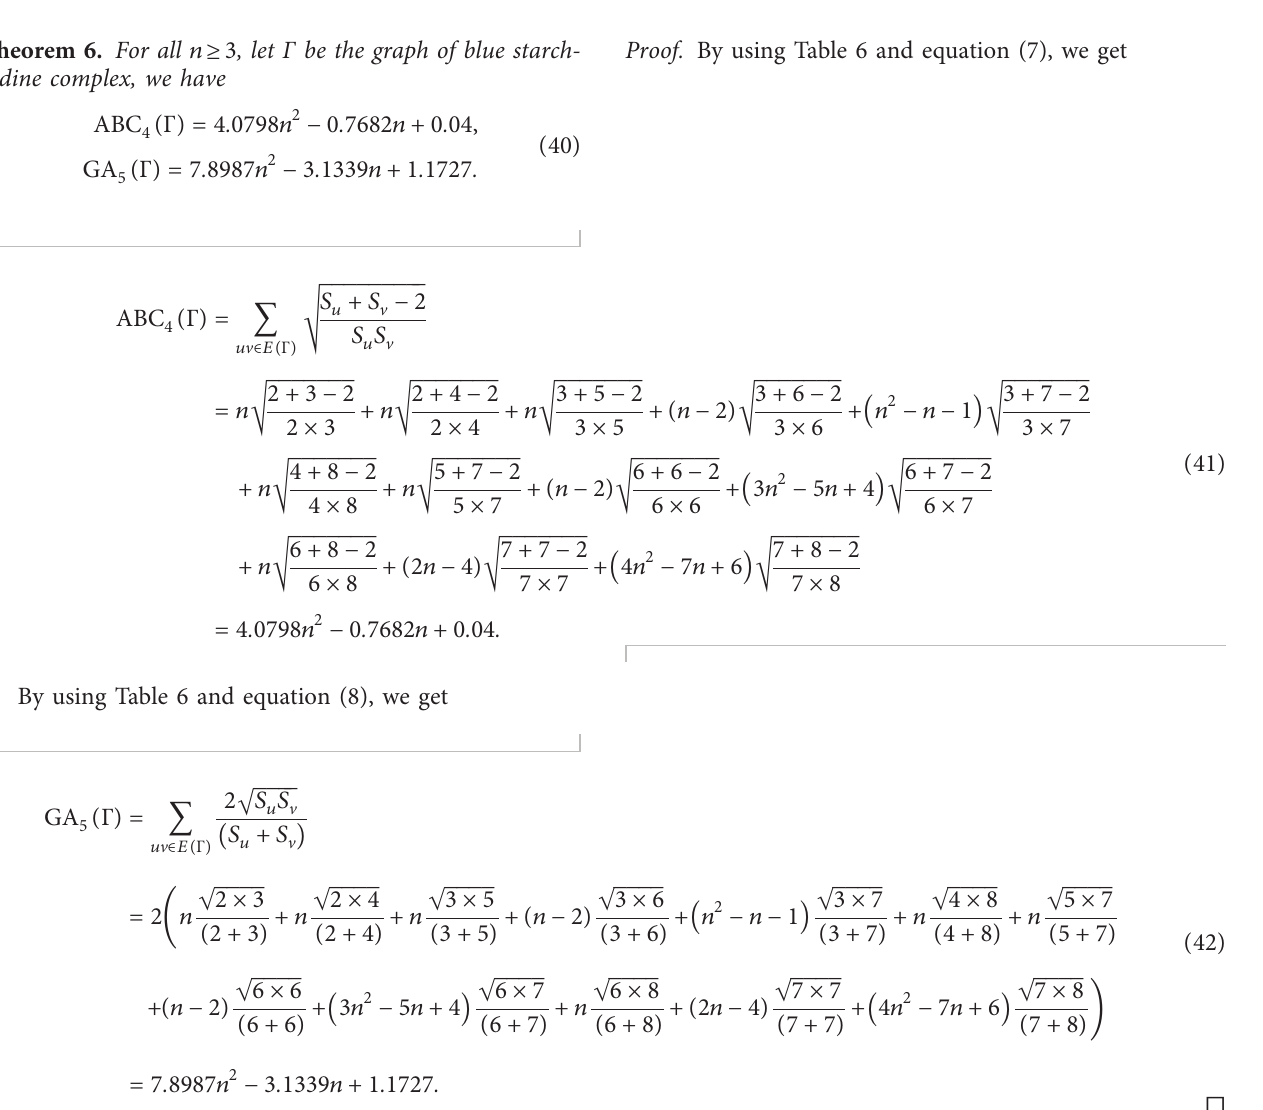
Table 8: Numerical comparison of ABC